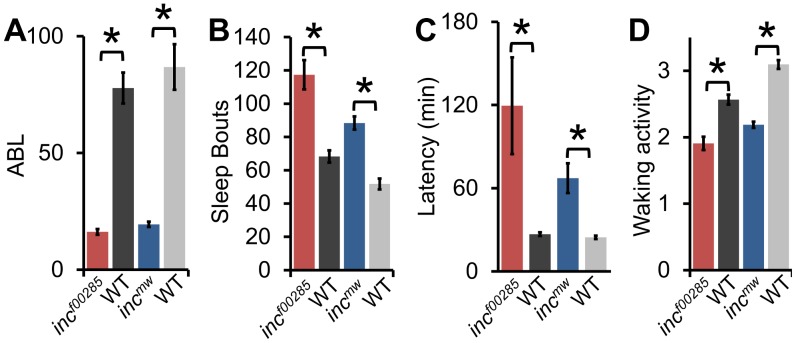
Sleep architecture is altered in inc mutants.(A) Average sleep bout length (ABL), (B) total number of sleep bouts, (C) latency to sleep after lights-off, (D) and waking activity in incf00285 (red, n = 44 males), incf00285 isogenic control (WT, dark grey, n = 47 males), incmw (blue, n = 72 males), and incmw isogenic control (WT, light grey, n = 32 males). Error bars are SEM. * p<0.005 with Student's t test for all data except sleep bout length. Sleep bout length is not normally distributed; therefore, Mann-Whitney U Test was used.